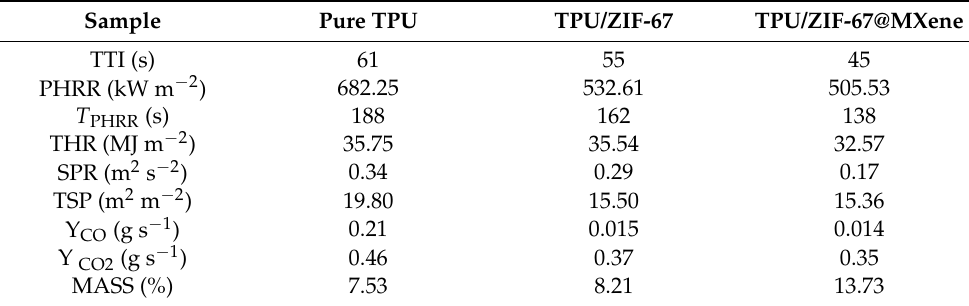
Figure 6. ( a ) CO and ( b ) CO 2 yield curves of TPU composites.